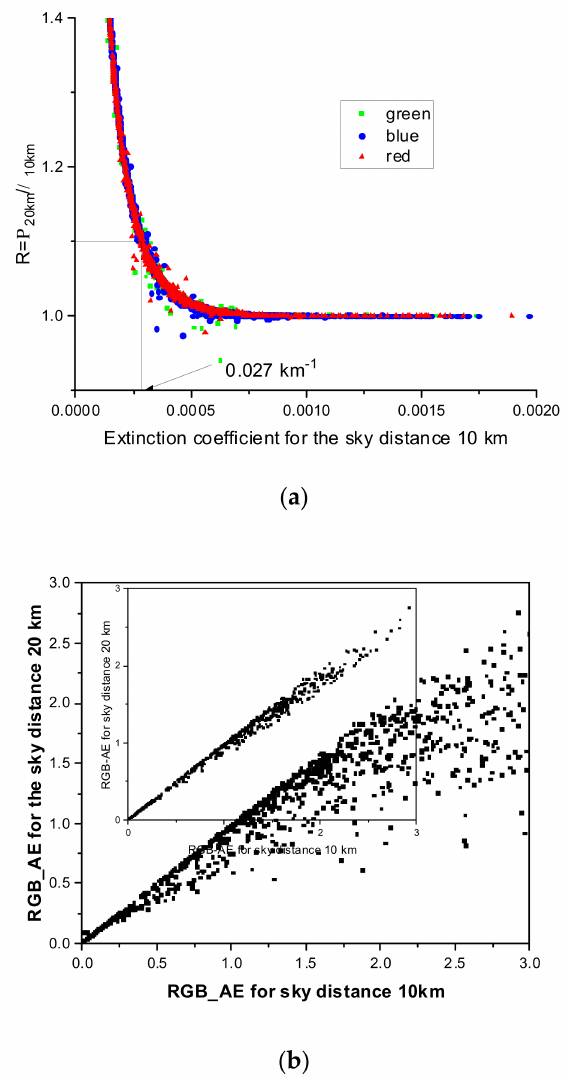
Figure 5. Comparison between two extinction coefficients and the RGB-AE variation calculated using two different sky target distances. ( a ) Comparison between two extinction coefficients calculated using two different sky target distances (10 km and 20 km) at RGB wavelengths. ( b ) Comparison between two RGB-AEs calculated using two different sky target distances for the RGB-AE ranges. The inset shows the same comparison for extinction coefficients ≥ 0.27 km − 1